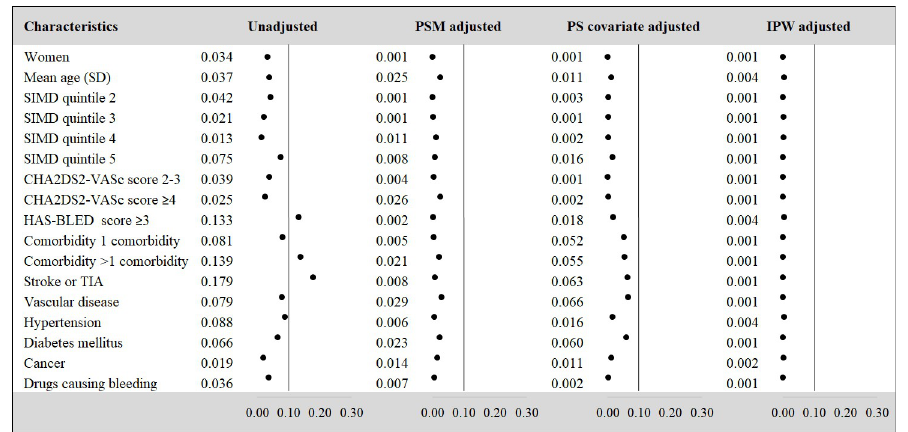
Fig 2. Covariate imbalance assessment for combined-DOACs vs. warfarin. Note: PS = Propensity Score, PSM = Propensity Score Matching, IPW = Inverse Probability Weighting, SIMD = Scottish Index of Multiple Deprivation, TIA = Transient Ischaemic